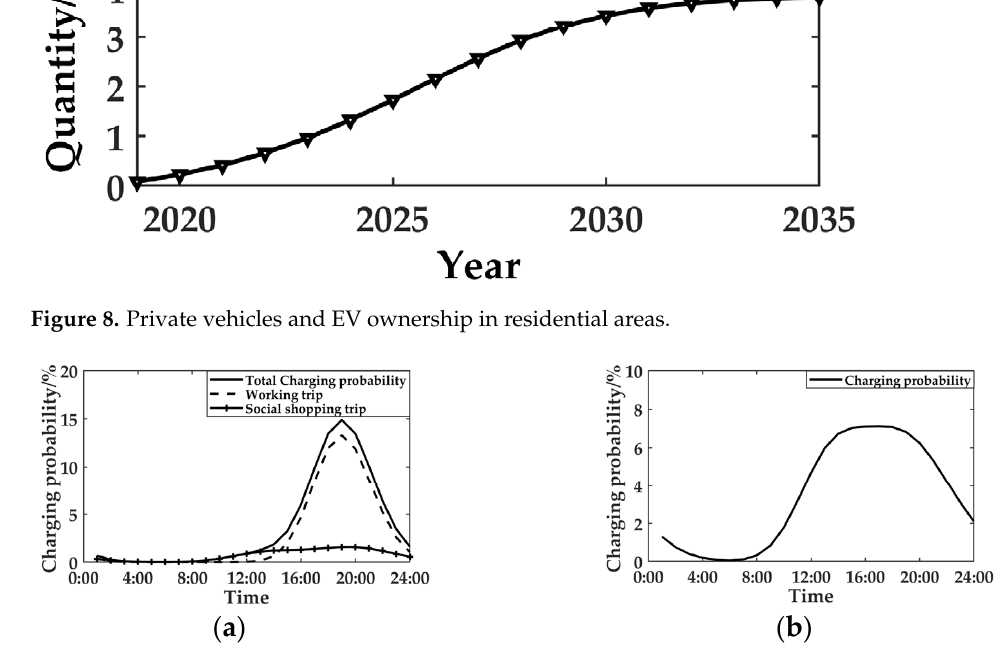
Figure 9. Charging probability of EVs in residential areas. ( a ) Weekdays, ( b ) Weekends. Table 4. Average charging time of EVs in residential